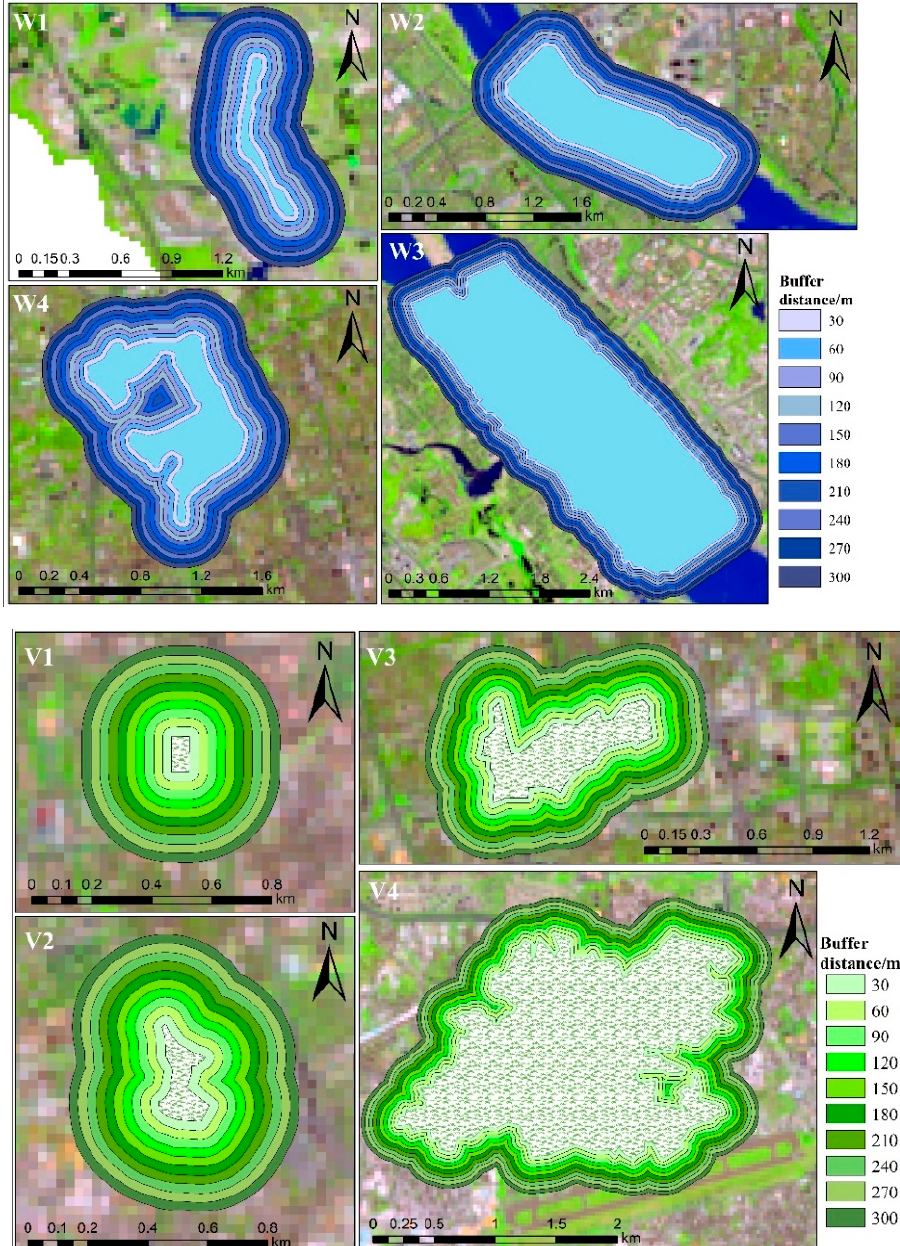
Figure 3. Buffer image of patches of different water or vegetation.